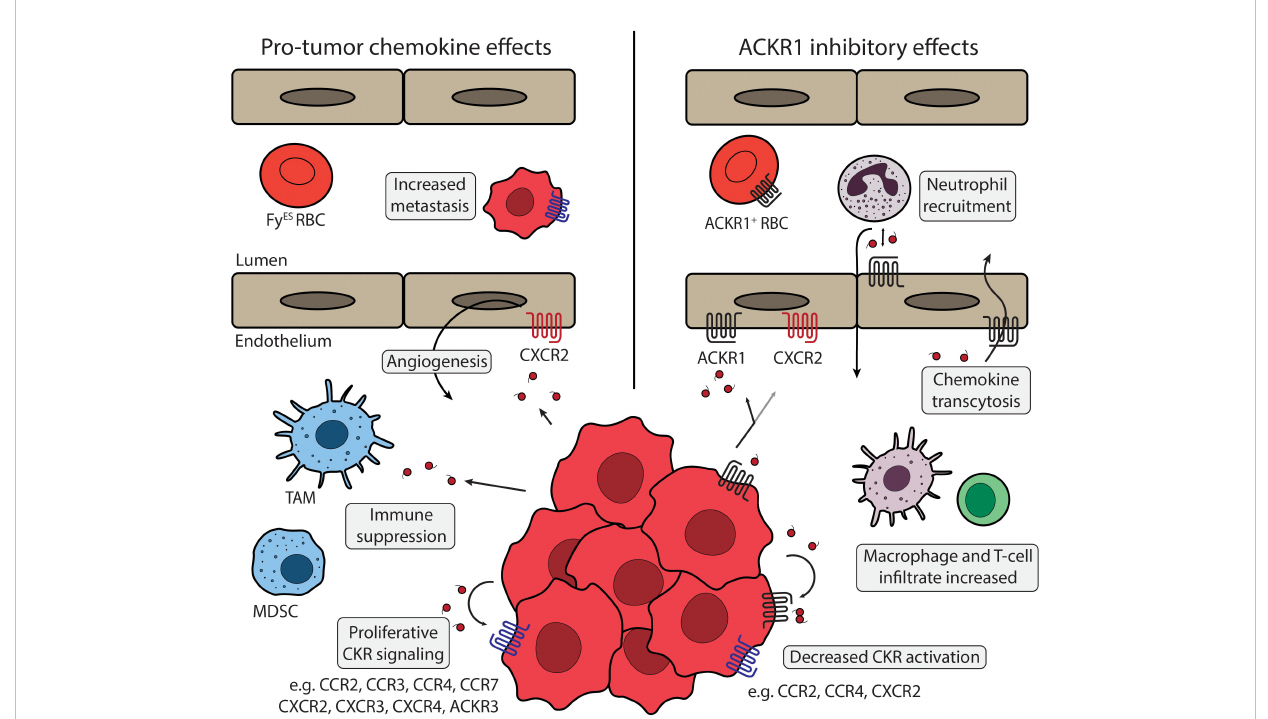
FIGURE 3 ACKR1 and tumor microenvironment Chemokine signaling in the tumor microenvironment is regulated by ACKR1 expression. Left panel describes chemokine effects that promote tumor phenotypes. ACKR1 (black) expression can be diminished on tumor cells or by the Fy ES polymorphism. Angiogenesis can be triggered by chemokines secreted from TAMs, stromal cells, or by cancer cells themselves via activation of endothelial CXCR2 (red). Cancer cells release numerous chemokines, including CCL2, CCL5, CXCL8, and others that can act to suppress anti-tumor immunity. Various cancer types express a panel of CKRs (blue) including CCR1, CCR2, CXCR2, CXCR4, and others that support tumor proliferation and metastasis. Primary tumors can silence expression of chemokines like CXCL12 and increase expression of CKRs like CXCR4 to promote metastasis. Right panel shows proposed mechanisms of ACKR1 regulation. ACKR1 receptors on erythrocytes can act as a sink to buffer chemokine levels and may have interactions with ACKR1 expressed on endothelial cells. ACKR1 enrichment at endothelial junctions promotes neutrophil diapedesis via CXCL1